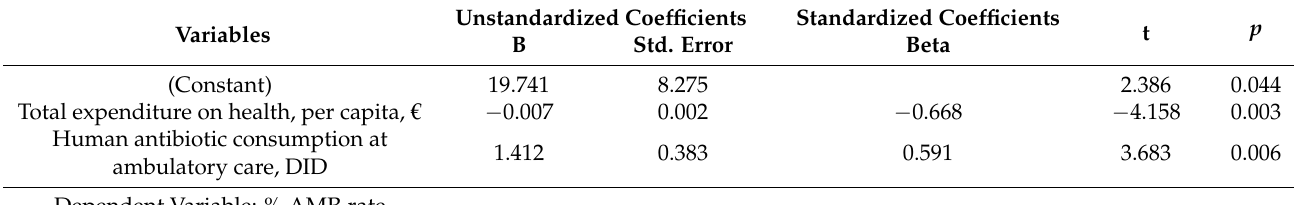
Table 3. Multiple linear regression model for % AMR